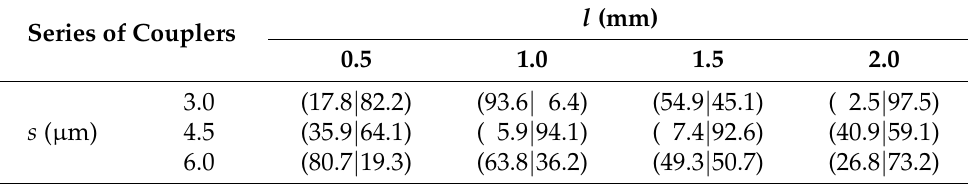
Table 1. Normalized powers P 1 | P 2 at coupler’s outputs 1 and 2, respectively. Series of